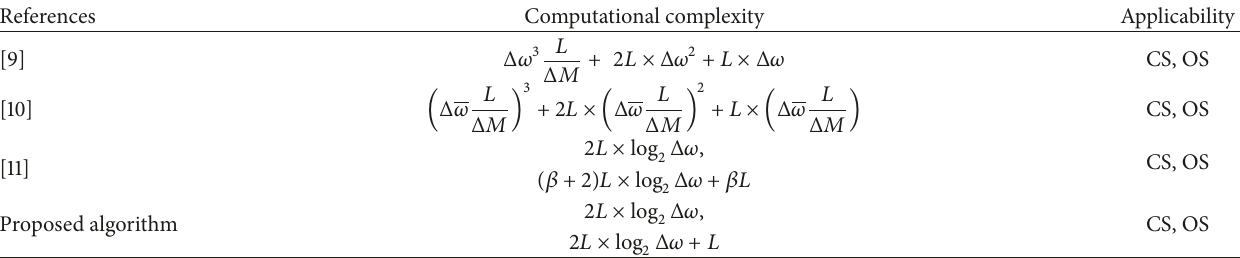
Table 2: Comparison of computational complexity between proposed approach and other existing